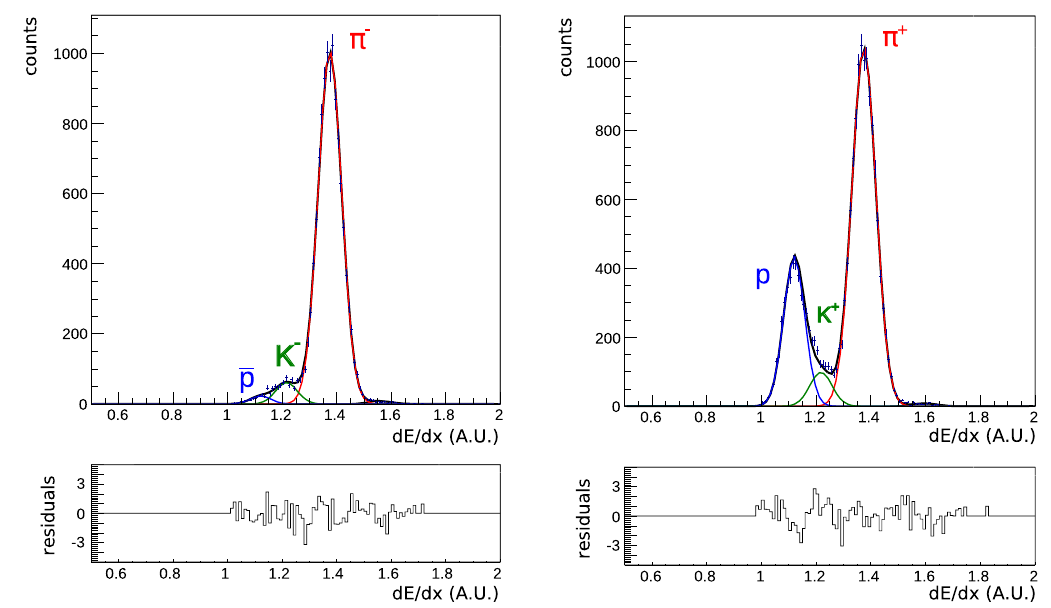
Fig. 8 The d E / d x distributions for negatively (top, left) and positively (top, right) charged particles in the bin 12.6 ≤ p lab ≤ 15.8 GeV / c and 0.2 ≤ p T ≤ 0.3 GeV / c produced in PSD selected Be+Be collisions at 75 A GeV / c . The fit by a sum of contributions from different particle